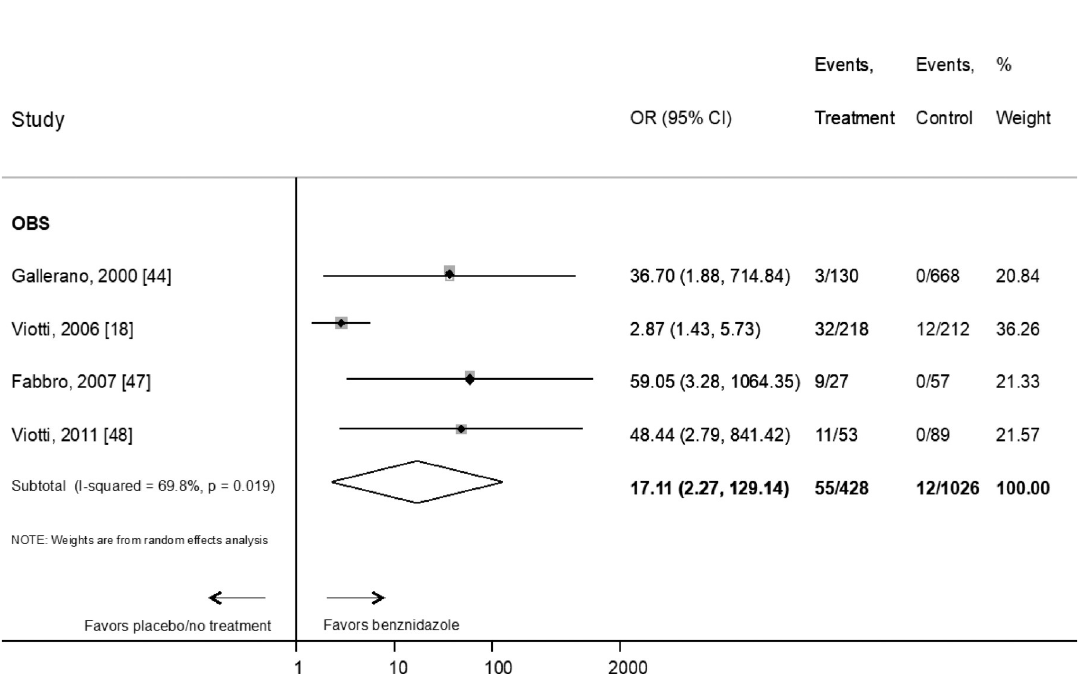
Fig 3. Evaluation of the effect of benznidazole compared with placebo or no treatment on the response to therapy in adults according to serological primary endpoint by type of study. RCT: Randomized Clinical Trial; OBS: prospective observational study. References: [44], [18], [47], [48].